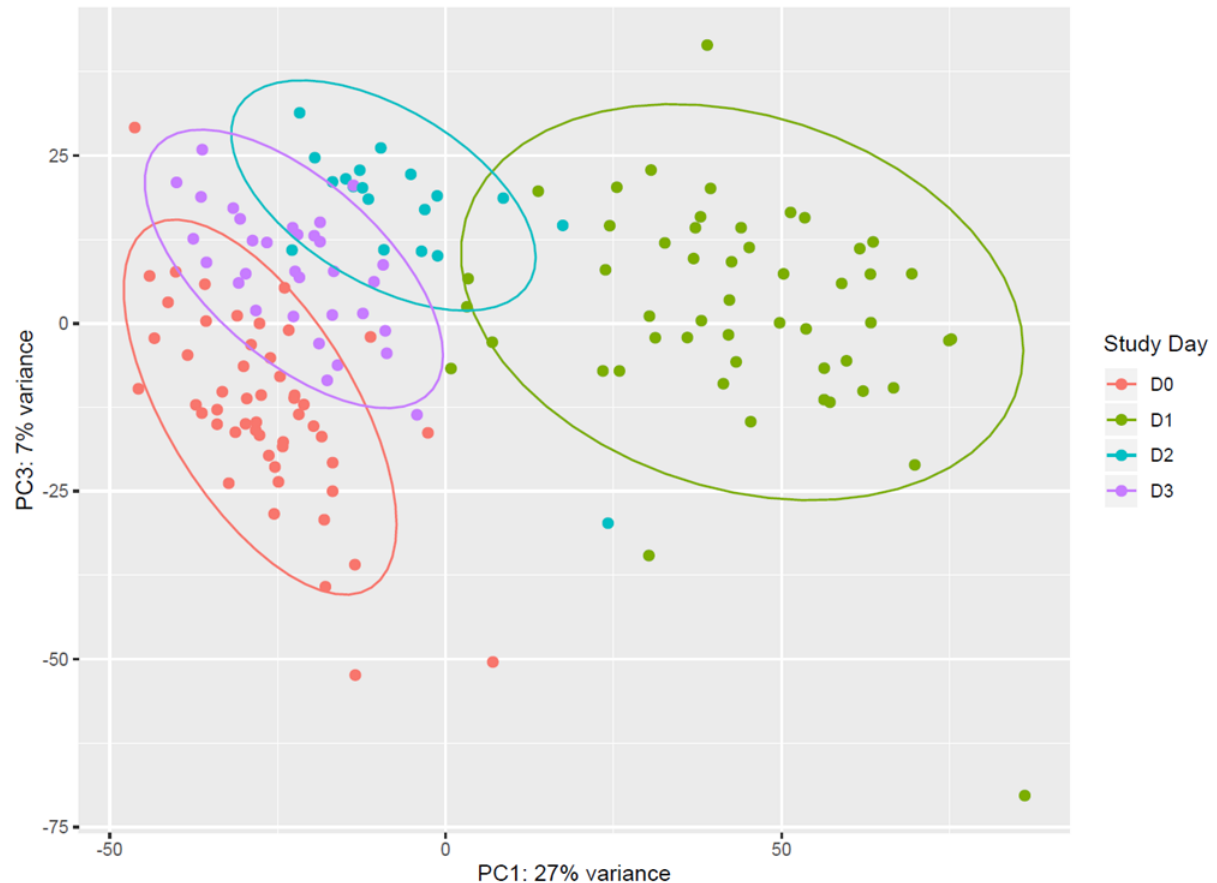
Figure 1. Principal component analysis of gene expression. Data from pre-vaccination (D0, red) and from the first 3 days after vaccination (D1, green; D2, light blue; D3, purple.) are reported in the principal component analysis (PCA) plot. Each dot represents a sample and the distance between samples reflects the variance in gene expression. Plot indicates a clear clustering of data by day of sampling. D0 and D1 data are very well separated along the PC1 axis, and appear more distributed along the PC3 axis than D2 and D3. Data from D2 and D3 are well separated from D1, while they tend to cluster with D0. Coloured ellipses define the normal confidence interval (95%) for each group of samples. Principal Component 1 (27% of total variance) and Principal Component 3 (7% of total variance) were chosen for this plot, as the plot produced using Principal Component 1 and Principal Component 2 (11% of total variance) was less discriminative (data not